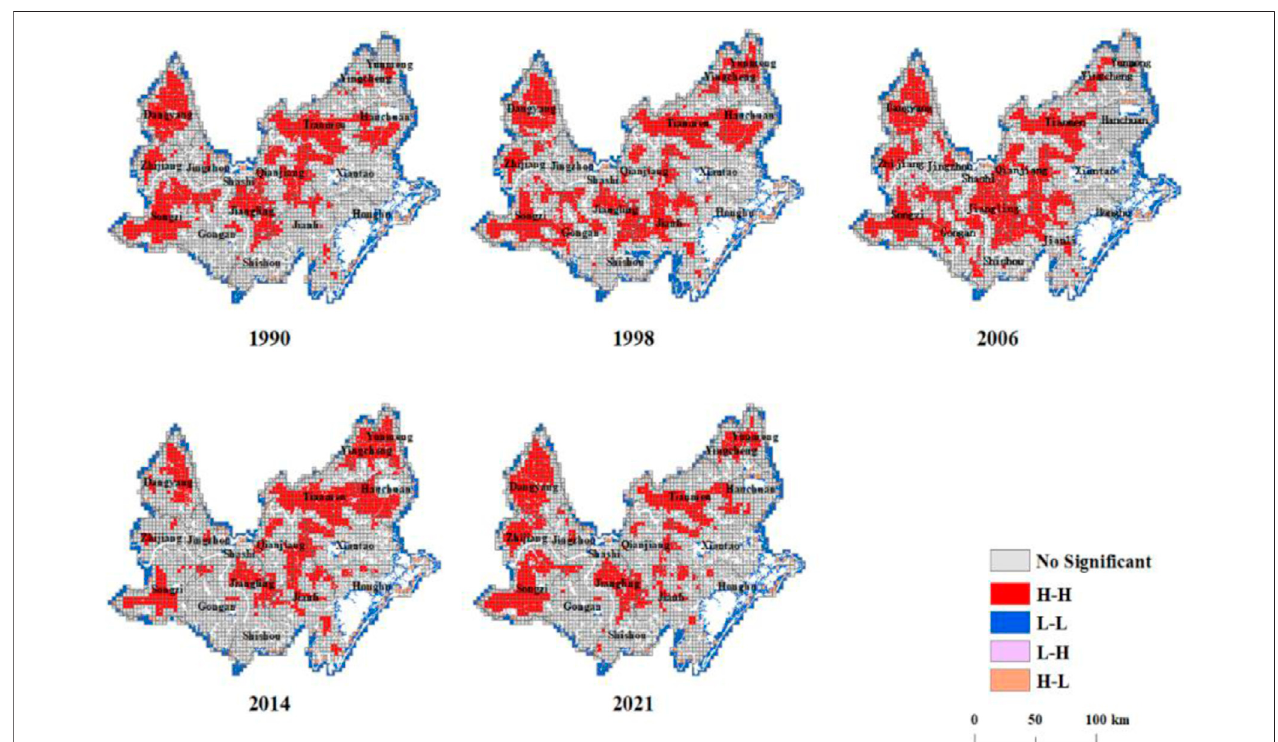
FIGURE 8 | LISA of the RSEI on the Jianghan Plain from 1990 to